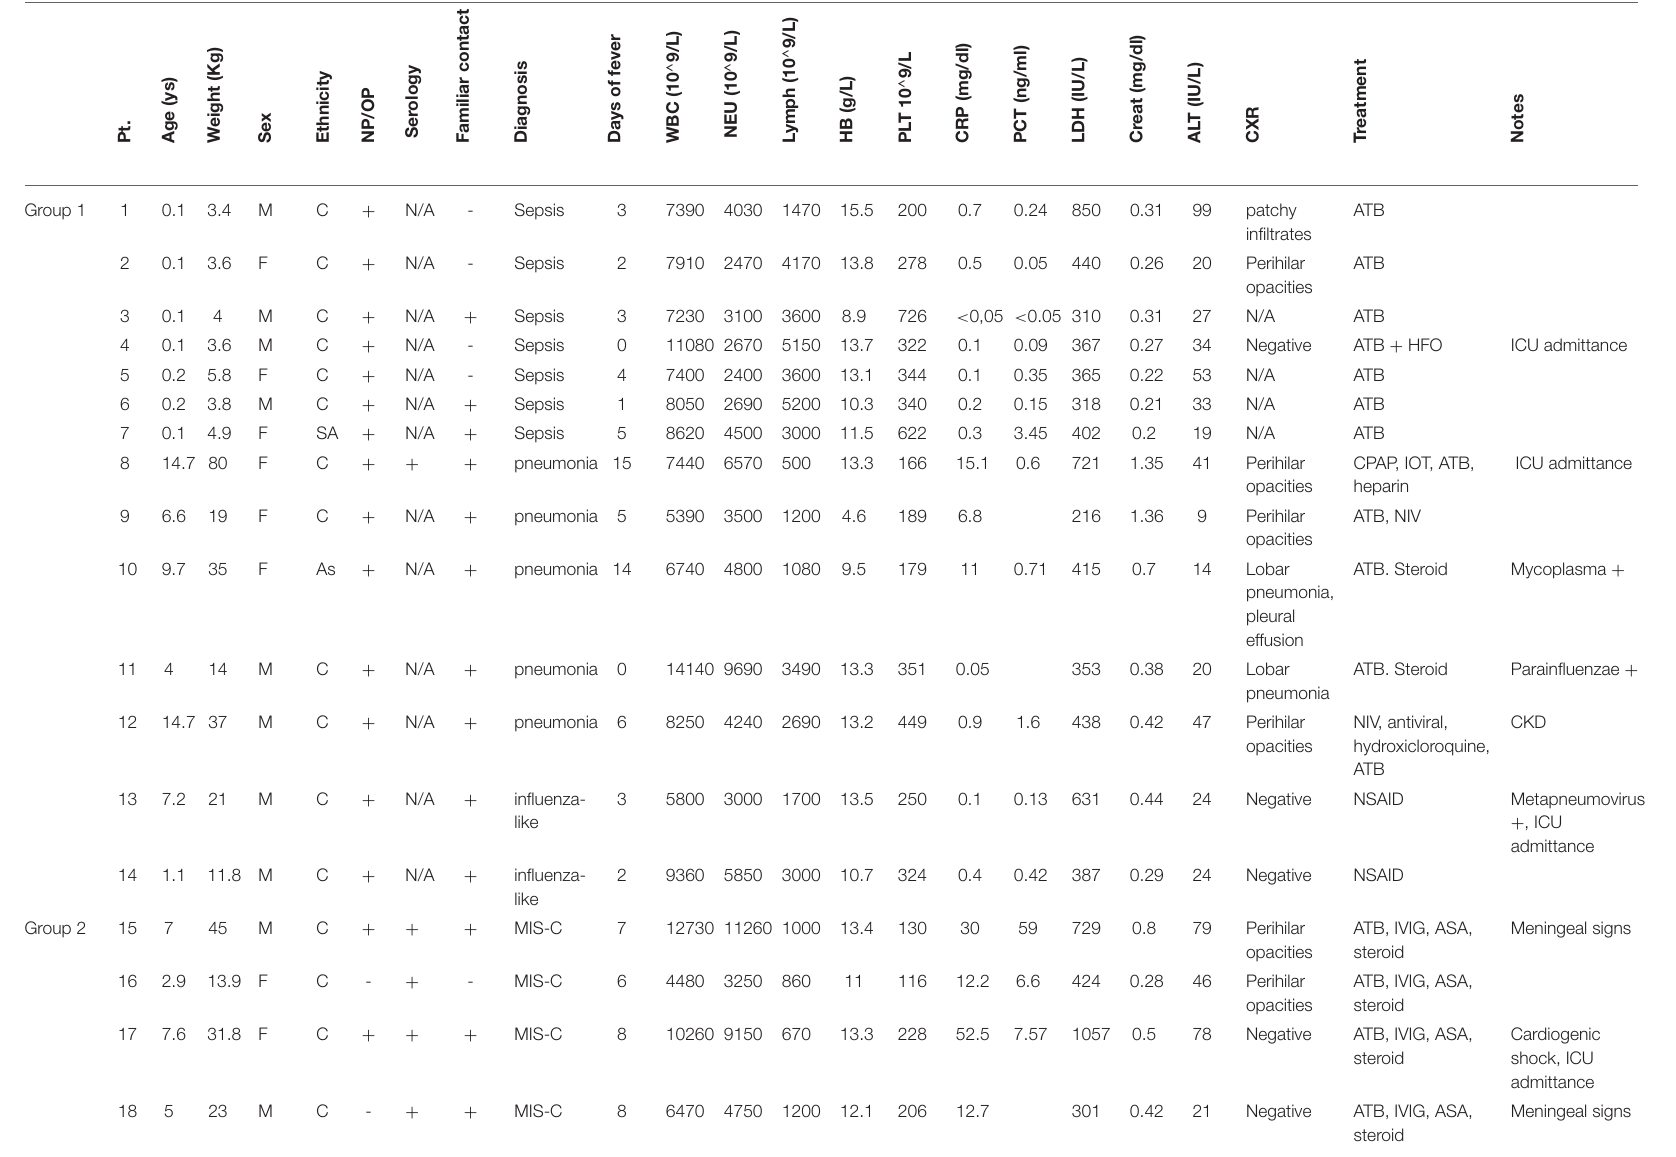
TABLE 1 | Demographic and clinical features of all patients observed in the study